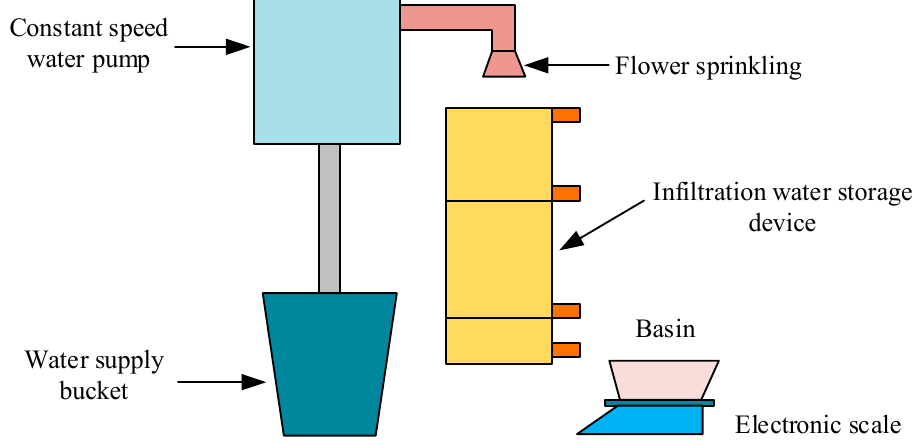
Figure 1. Schematic diagram of seepage storage